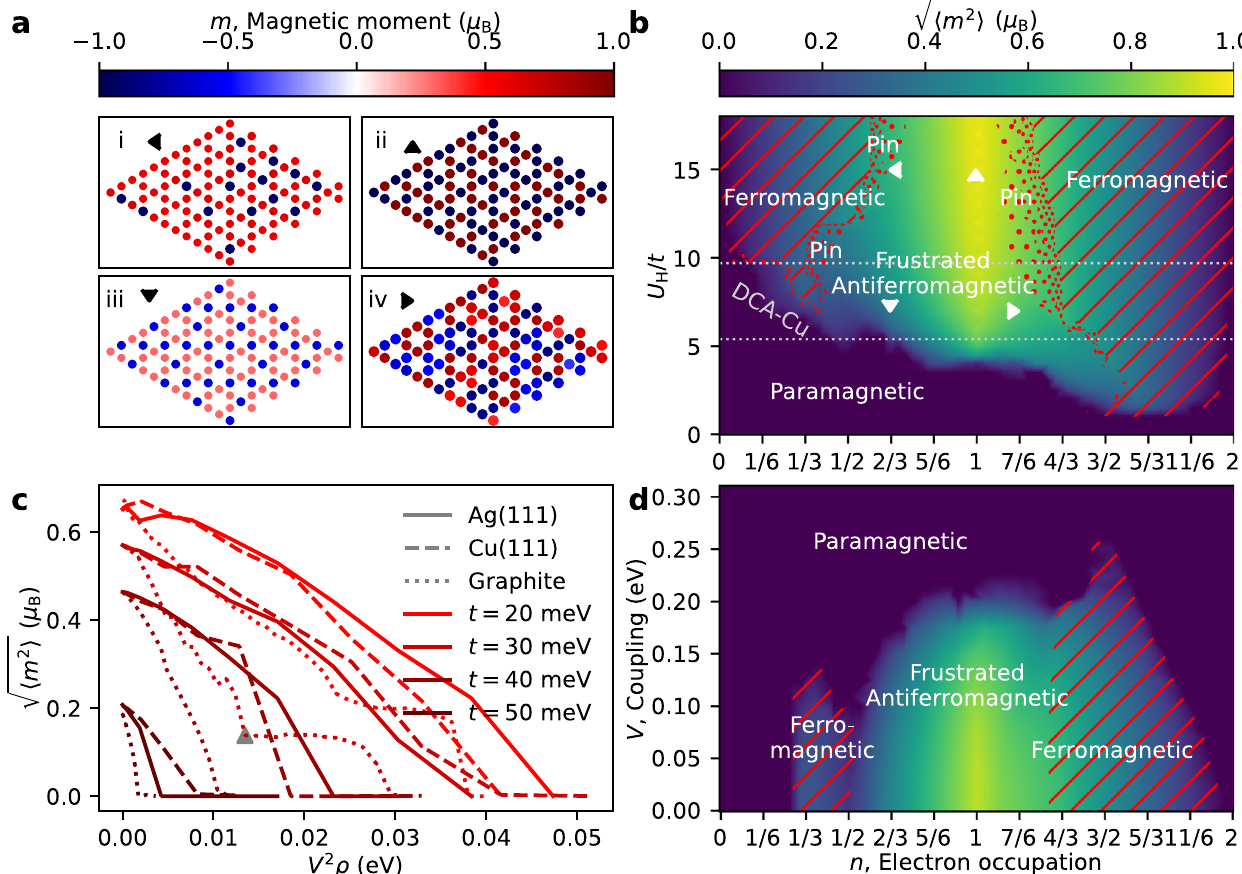
Fig. 5 Emergent magnetism in the kagome lattice from our mean- fi eld Hubbard model. a Real-space magnetisation densities in a free- standing kagome lattice. We show a pinned metal droplet phase 23 (i), a spin-density-wave phase (iii), and two disordered phases (ii, iv). b Magnetic phase diagram of the free-standing kagome lattice in a supercell. The red dotted region indicates the transition from antiferromagnetic to ferromagnetic phase, with a partial net polarisation (Supplementary Fig. 4). ‘ Pin ’ refers to a pinned metal droplet phase. Triangular markers indicate phase space locations corresponding to a . Dotted horizontal lines indicate the range of U H / t values that reproduce the DFT results for DCA-Cu (Supplementary Table 1 and Supplementary Fig. 9). c Effect of effective hybridisation V 2 ρ and MOF hopping parameter t (proportional to lattice bandwidth) on the strength of magnetic moments for different substrates. The substrate density of states ρ is taken as the mean DOS of the substrate dispersions over ± 0.2 eV around the Fermi level, which is 0.76, 0.82, and 0.035 eV − 1 for Ag(111), Cu(111), and graphite, respectively. The kink in the t = 30 meV graphite curve (gray triangular marker) is due to an antiferromagnetic to ferromagnetic phase transition (see Supplementary Note 1). Data obtained using U H = 300 meV and an electron occupation of approximately 2/3. d Effect of electron occupation and coupling to a substrate on the strength of magnetic moments. Magnetic phases can withstand higher coupling with the substrate at higher electron occupations than at lower electron occupations. Data obtained using a single kagome unit cell, U H = 300 meV, t = 40 meV, and the Ag(111)